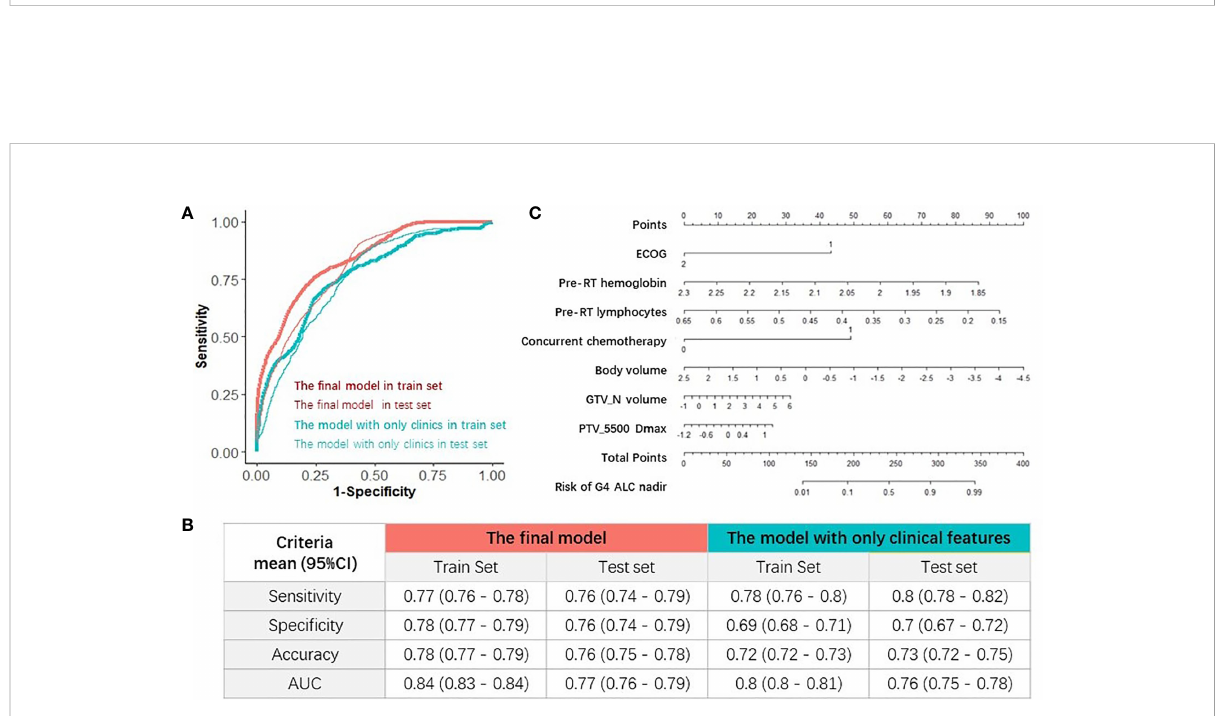
FIGURE 5 Evaluations of the models and nomogram for G4 ALC nadir prediction. (A) One example of receiver operating characteristic (ROC) curve of the prediction models in train and test sets. (B) Comparison of four evaluation criteria of different prediction models in train and test sets. (C) Nomogram of the fi nal prediction model with seven